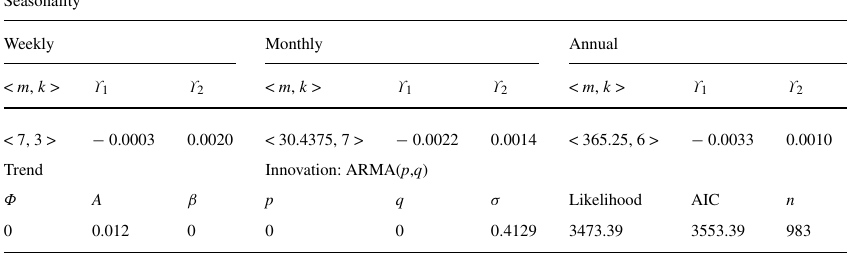
Table.2 Estimation of TBATS parameters